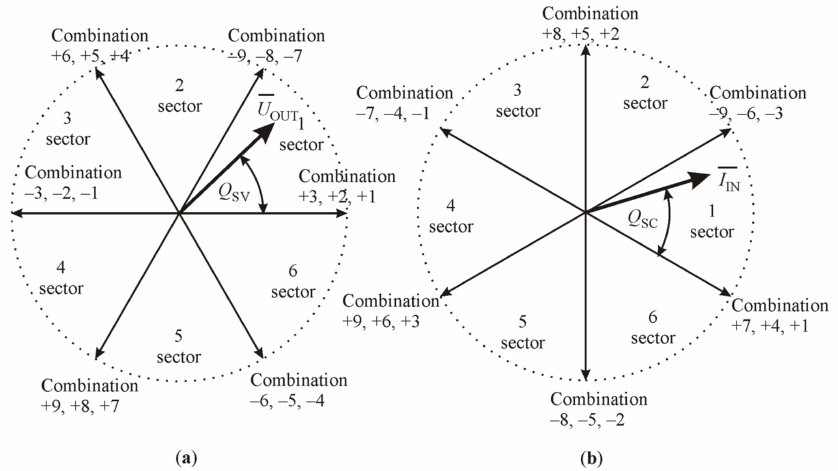
Figure 8. Graphics of the active vectors presented in Table 4: ( a ) graphic of the motor stator windings voltage vectors; ( b ) graphic of the PDL current vectors.